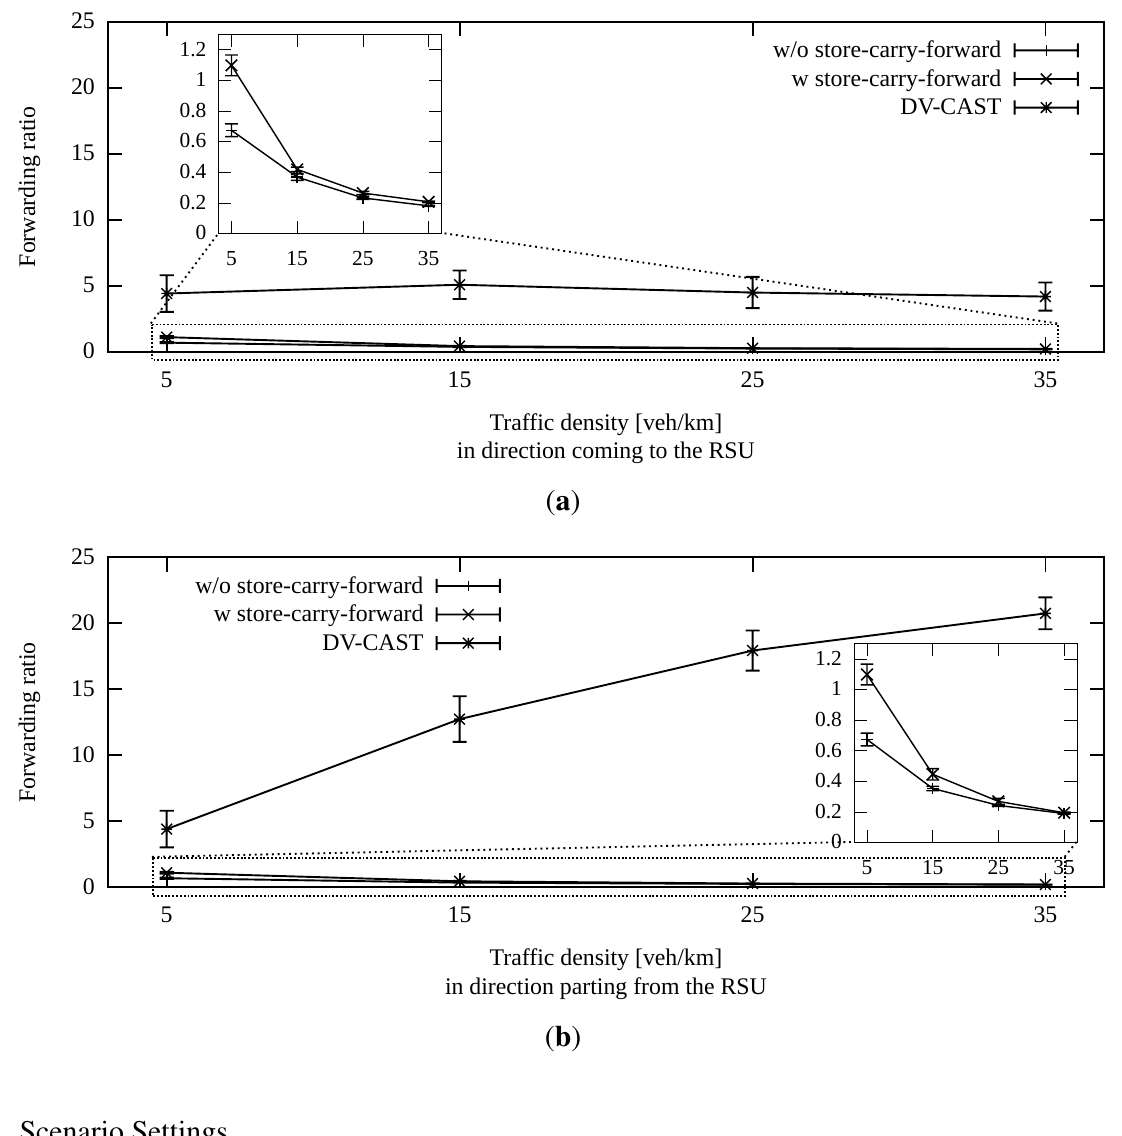
Figure 13. Overhead of our approach with and without store-carry-forward and of DV-CAST. Density variations in one direction influence the performance. The other direction has a fixed traffic density of five vehicles/km. Confidence interval of 95%. ( a ) Five vehicles/km in the direction parting from the RSU; ( b ) five vehicles/km in the direction coming to the